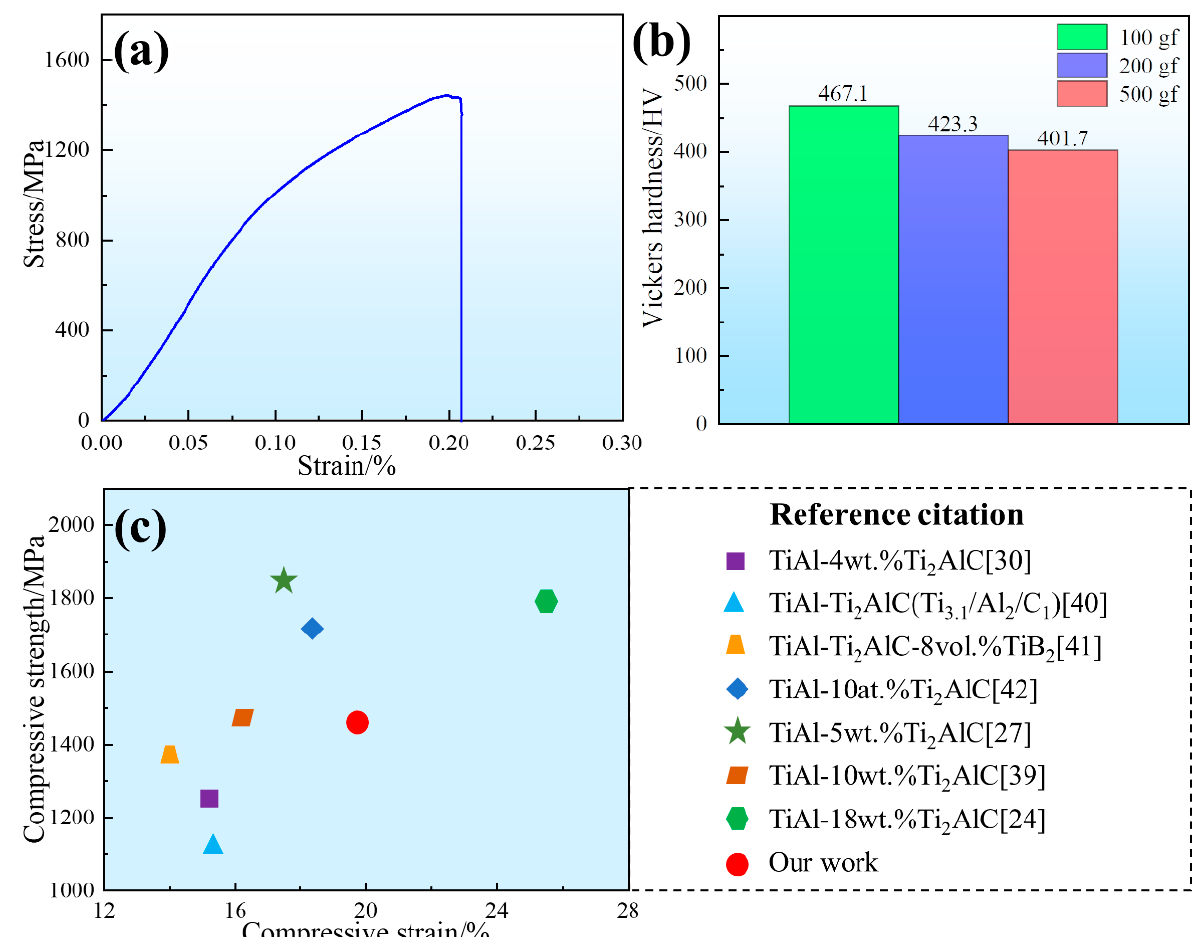
Figure 7. The compressive and hardness properties of the as-prepared Ti 2 AlC/TiAl composite: ( a ) compressive stress–strain curve; ( b ) Vickers hardness under loads of 100 gf, 200 gf and 500 gf; ( c ) comparison of the compressive properties of other Ti 2 AlC/TiAl composites in [24,27,30,39–42].